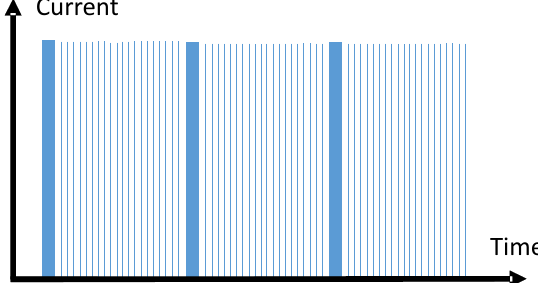
Fig. 6. Example of the proton pulse structure on SONATE. Long pulses (2ms, 20Hz) are interleaved with short pulse high repetition rate pulses (200µs, 100Hz). The long pulses are directed to a TMR station for low resolution instruments while the short pulses are directed to a second TMR station for higher resolution instruments. The first target would use a fraction of 4% of the duty cycle while the second target would use 2% of the duty cycle. Hence the accelerator should be designed to handle a 6% duty